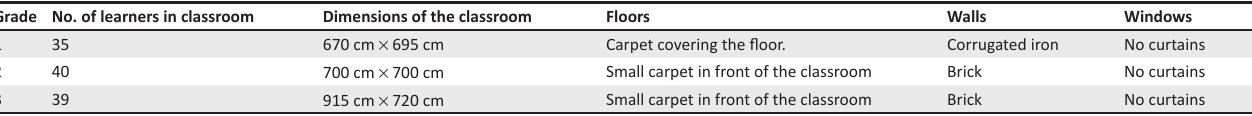
TABLE 1: Classroom descriptions.